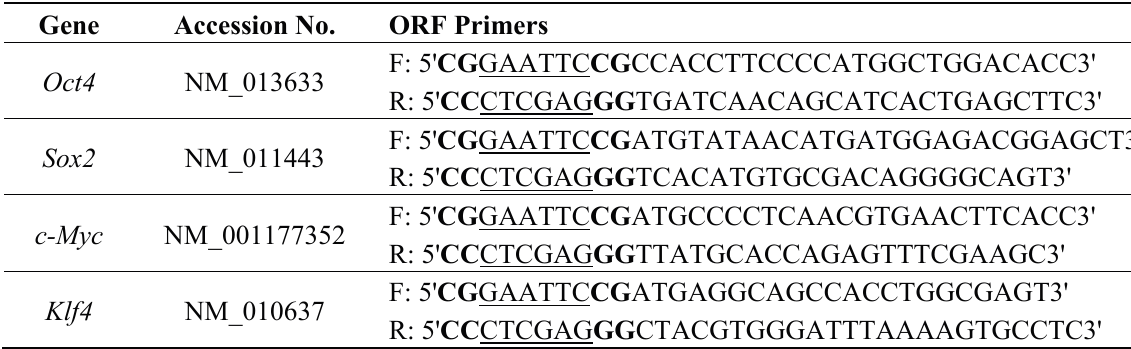
Table 1. Primers used for amplification of the genes of interest. The restriction sites were underlined. Eco RI and Xho I restriction sites were used in forward and reverse primers, respectively. The underlined areas are the restriction sites of the used enzymes and the bolded are the protective